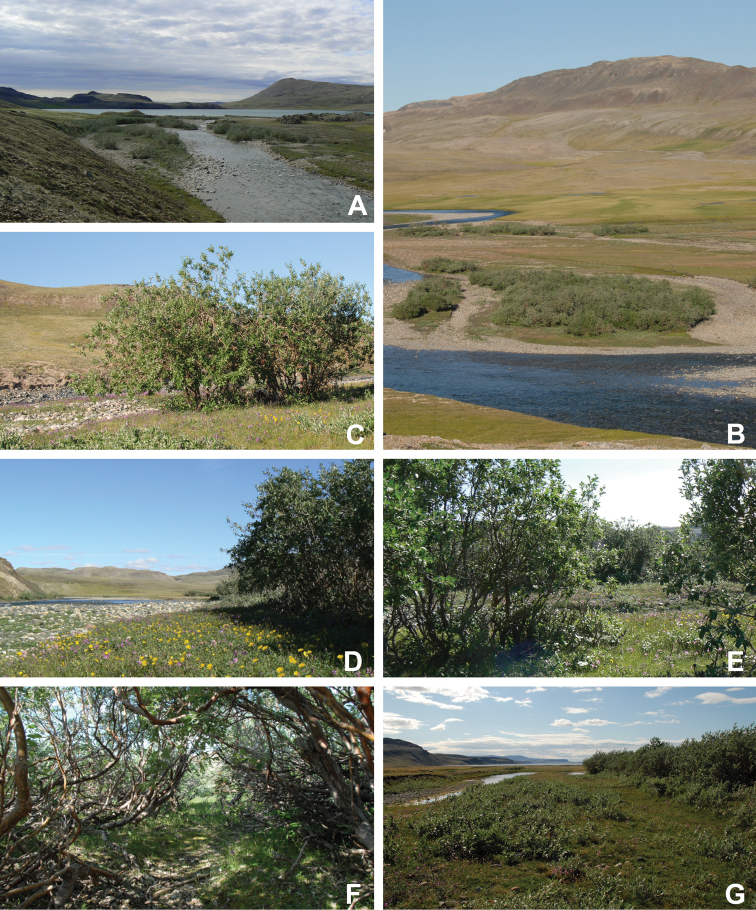
Salix
alaxensis
var.
alaxensisA habitat, vicinity of Boot Inlet, Gillespie et al 9577, 9578B habitat at the head of Minto Inlet C–G habit at the head of Minto Inlet, Gillespie et al 10191. Photos A, D by P.C. Sokoloff and B, C, E–G by L.J. Gillespie.